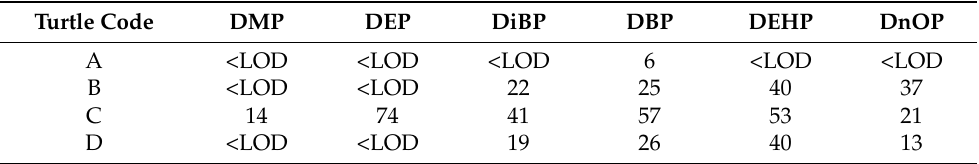
Table 6. PAEs concentration levels (ng mL − 1 ) determined in the blood of Caretta caretta turtles. For turtle codes: see Table 2. For PAE acronyms: see Table 1. Turtle Code DMP DEP DiBP DBP DEHP DnOP A <LOD <LOD <LOD 6 <LOD <LOD B <LOD <LOD